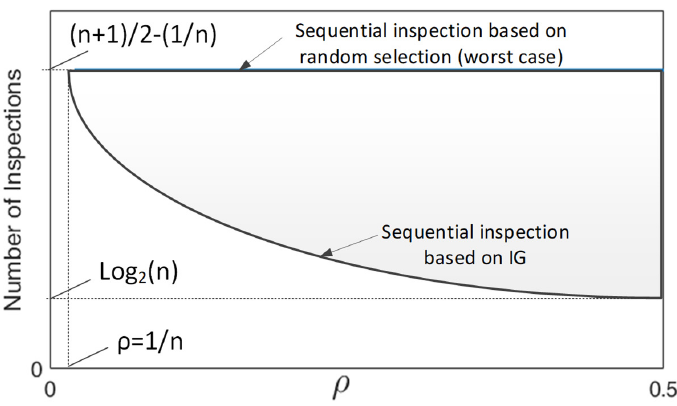
Figure 7. Expected evolution of the required average number of inspections for fault diagnosis under a sequential inspection based on IG and a random selection.